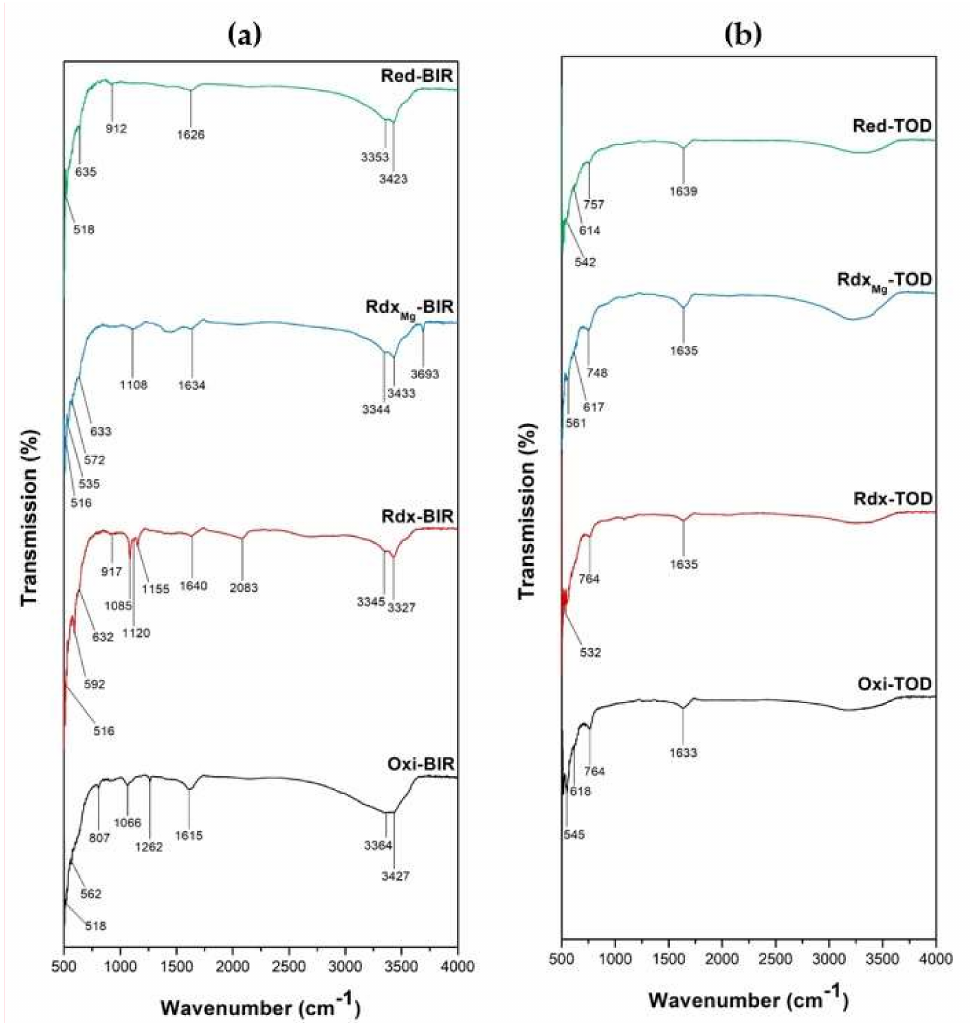
Figure 4. Infrared (IR) spectra of the synthetic manganese oxides: birnessite ( a ) and todorokite ( b